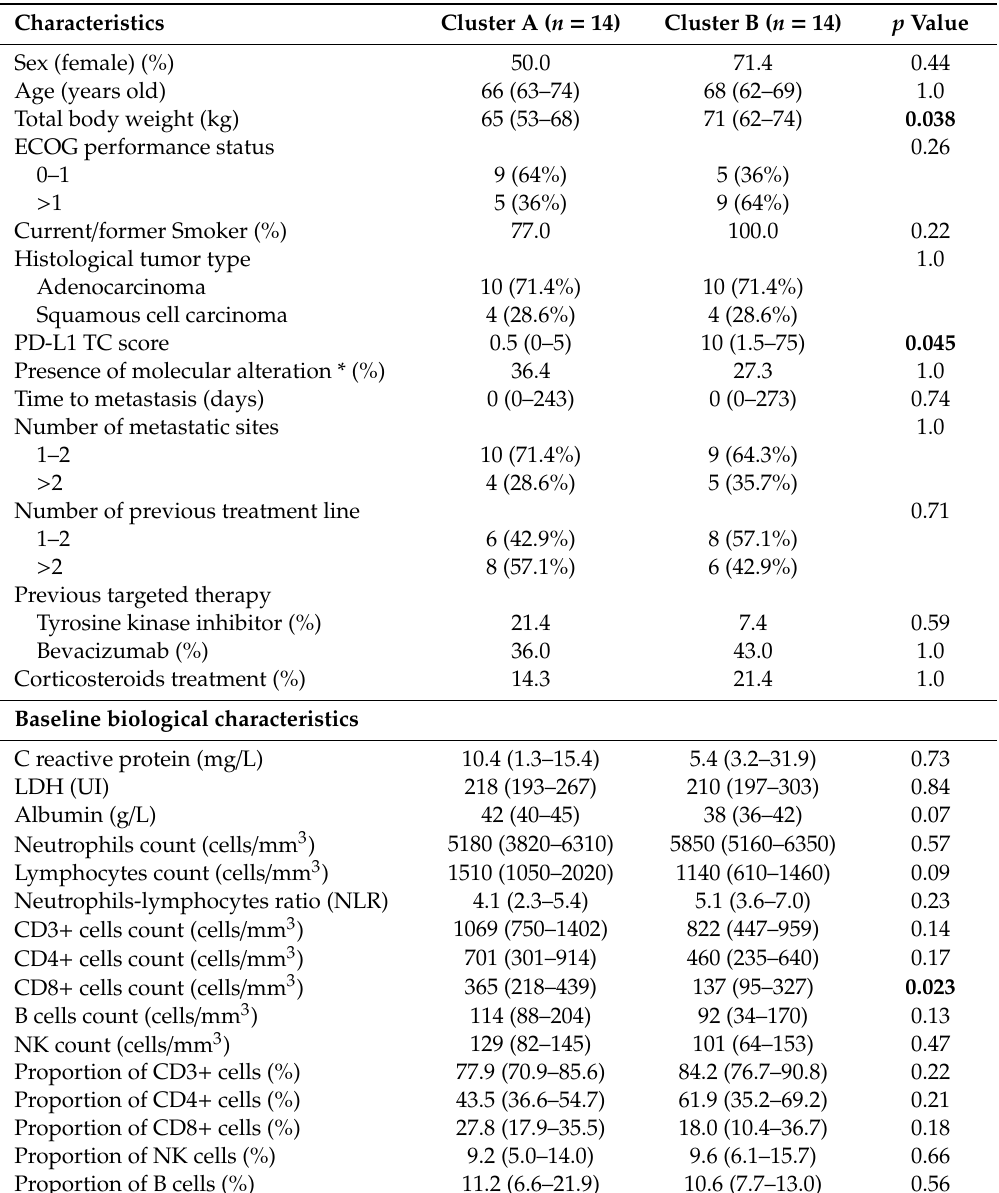
Table 2. Characteristics of the two clusters A and B of non-small-cell lung cancer patients identified before treatment start